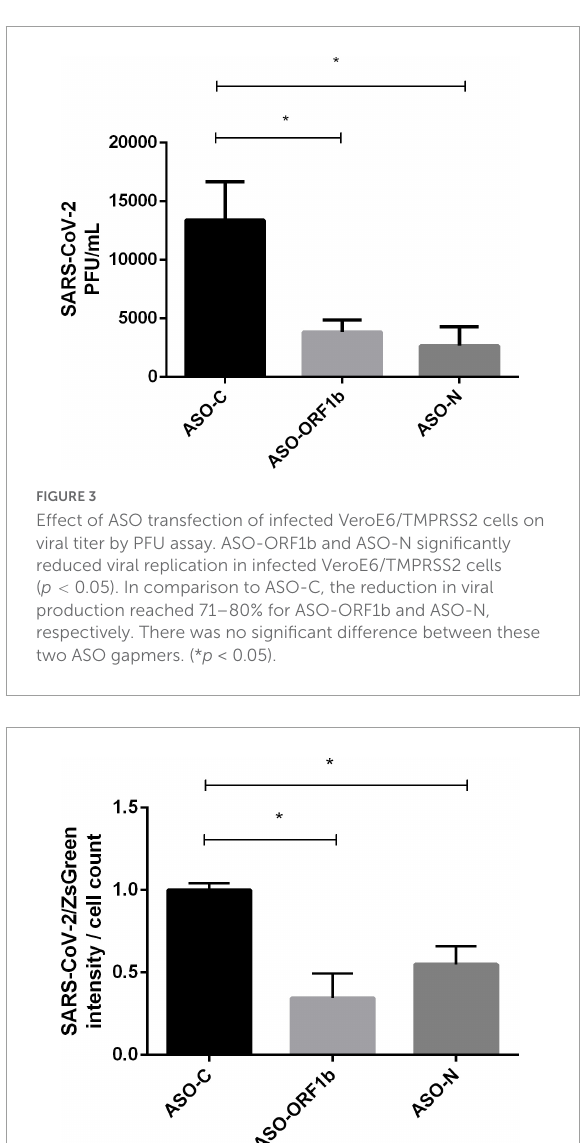
FIGURE4 Effect of ASO transfection on VeroE6/TMPRSS2 cells infected with recombinant reporter SARS-CoV-2/ZsGreen viral particles. Cells were transfected with ASO-ORF1b, ASO-ORF-N or ASO-C and infected 5 h later with SARS-CoV-2/ZsGreen viral particles at a MOI of 0.1. Total fluorescence per well was measured by fluorometry (Tecan). Fluorescence intensity was significantly reduced in cells transfected with ASO-ORF1b (–65%) and ASO-N (–45%), compared to ASO-C ( p < 0.05). (* p < 0.05).